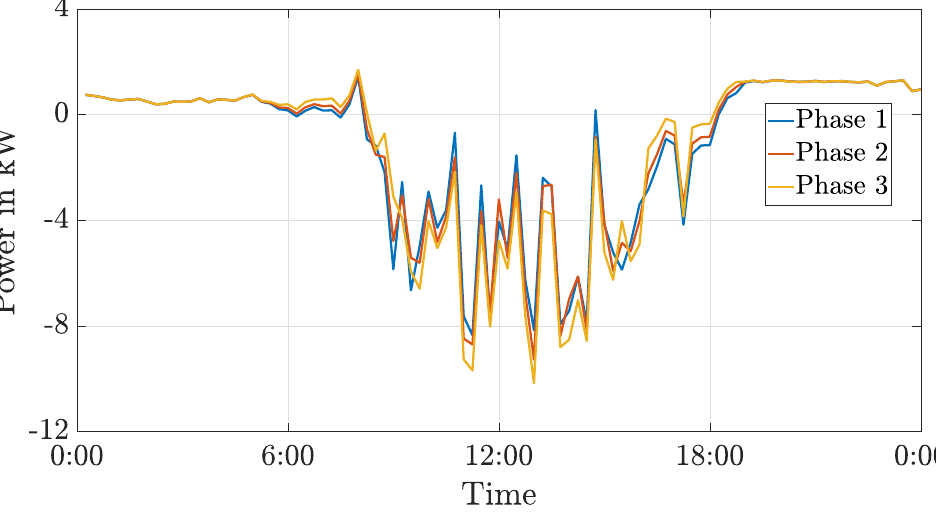
Figure 16. Total power import per